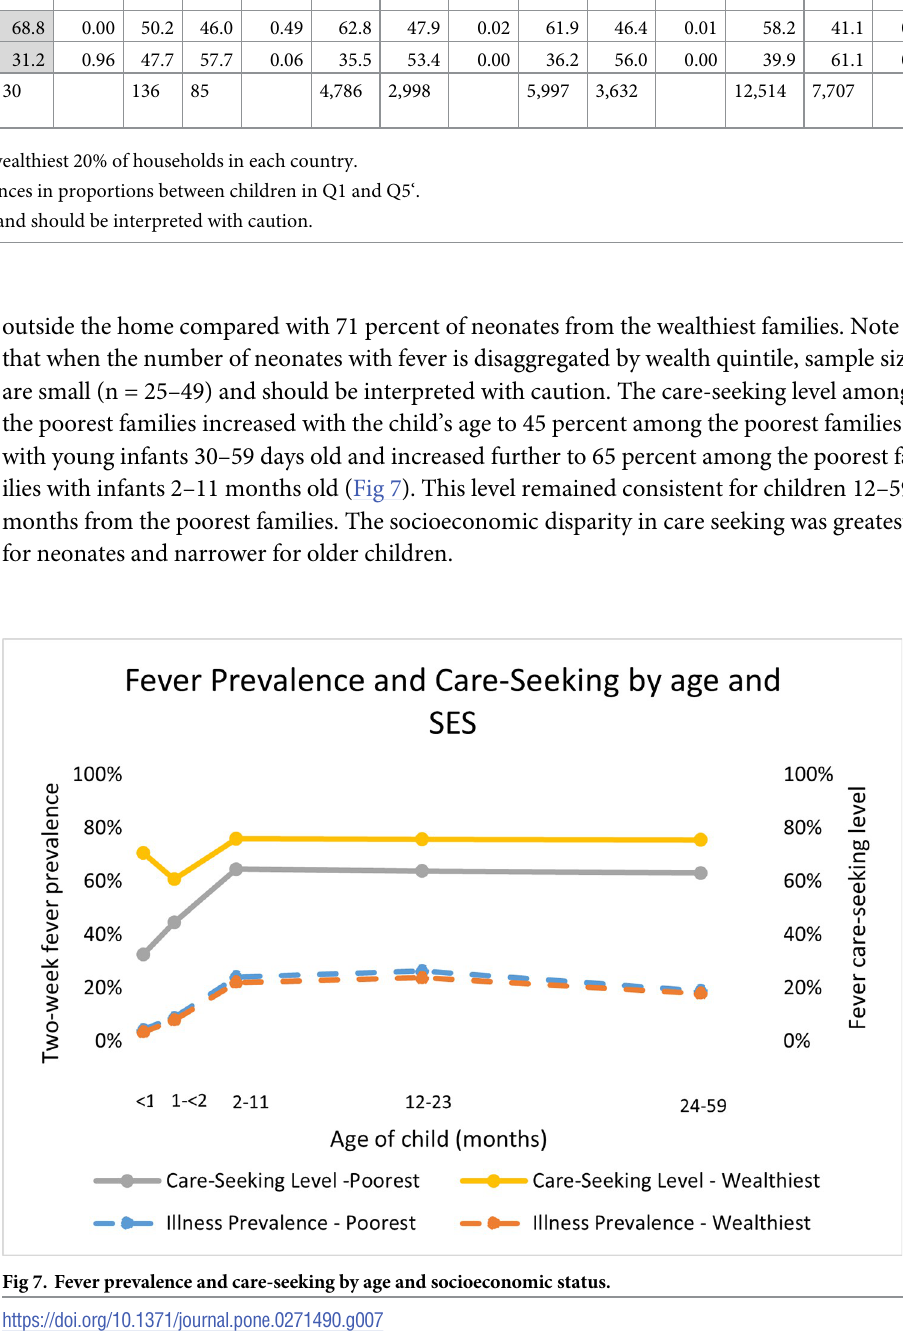
Fig 7. Fever prevalence and care-seeking by age and socioeconomic status.